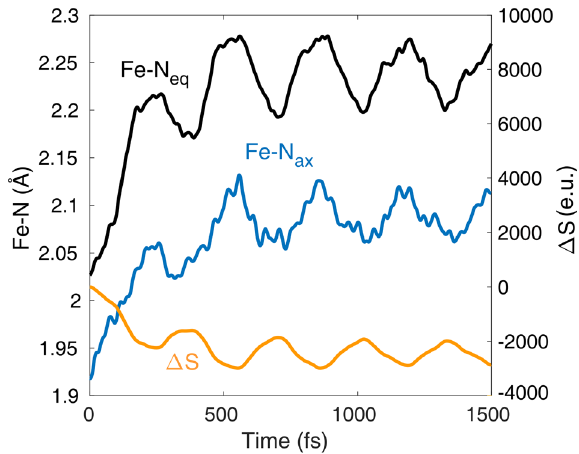
Fig. 4 Average trajectories along Fe-N ax and Fe-N eq and the simulated difference X-ray scattering signal Δ S . N ax and N eq denote the axial and equatorial N atoms, see Fig. 1a. Δ S is referenced to t = 0 fs, at q = 0.5 Å − 1 , which is characteristic for Fe(II)